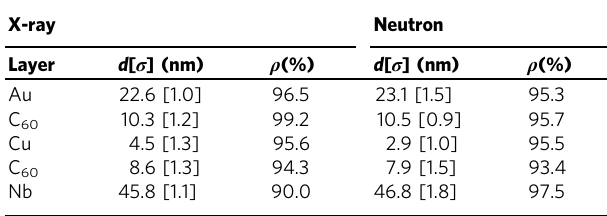
The X-ray and neutron re fl ectivity data have been modelled with GenX using the presented fi lm thickness ( d ), rms roughness ( σ ) and density ( ρ ) of each layer. The density has been presented as a percentage w.r.t. the